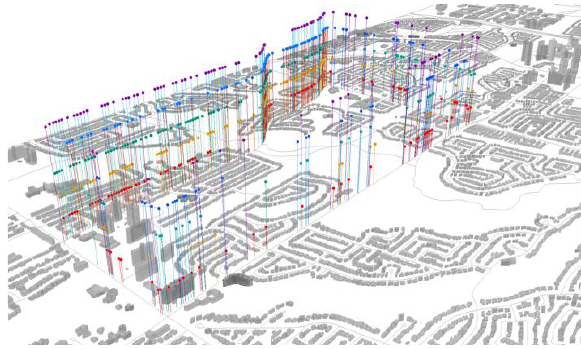
Figure 4. Spatiotemporal representation of detected road surface anomalies